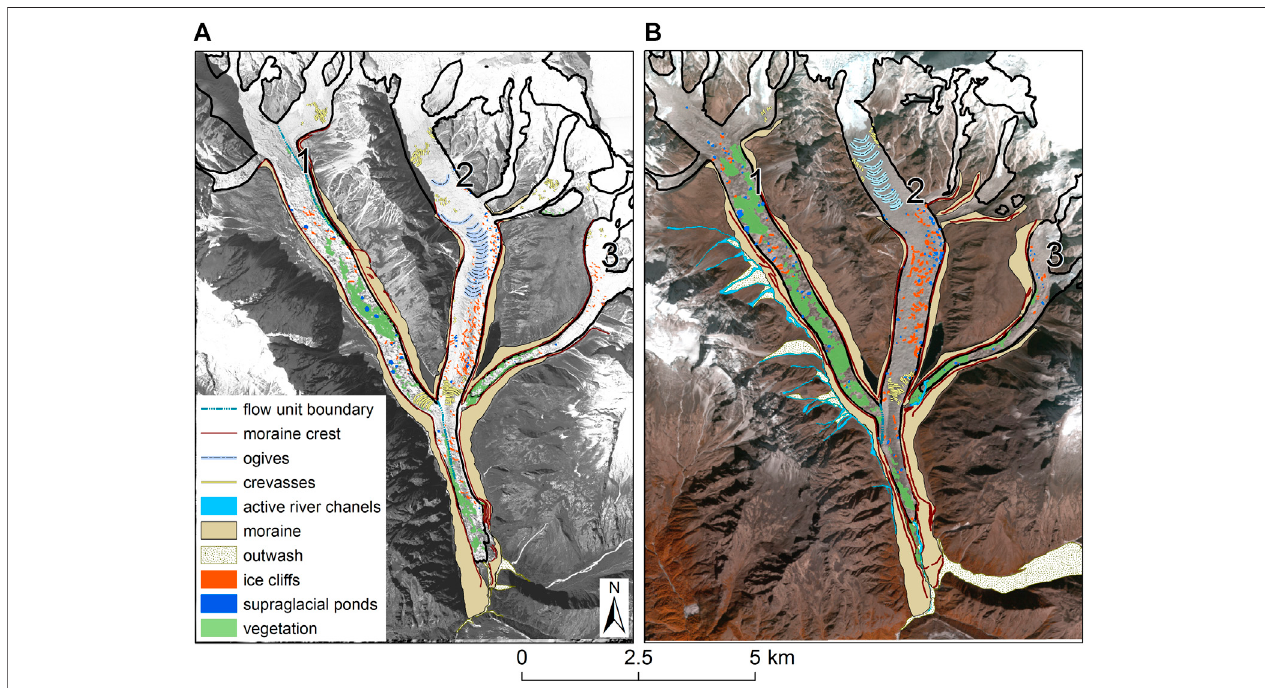
FIGURE 9 | Geomorphology and ice-surface changes for the Ponkar Glacier system for period 1970 to 2019: (A) interpretation based on the Corona 1970 panchromatic image; (B) interpretation based on RapidEye 2019 false colour composite bands 543.